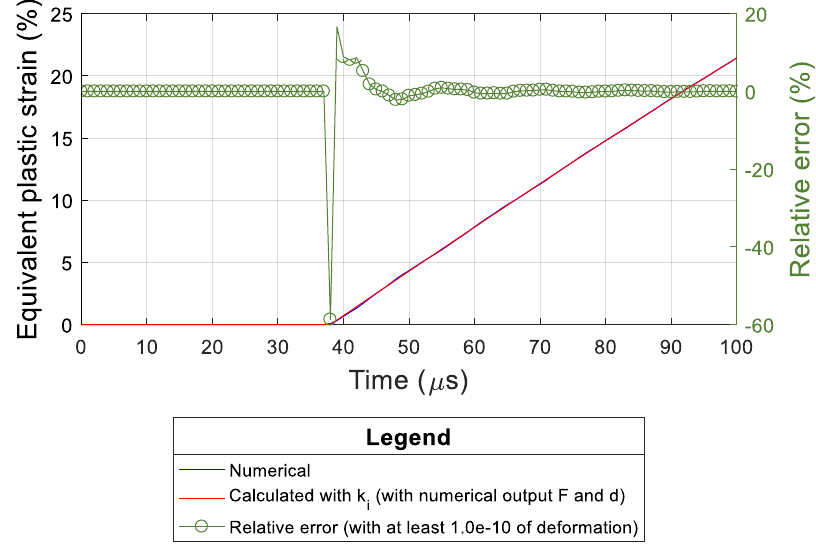
Figure A6. Comparison of ε eq,num with ε eq,calc. versus time obtained in the shear zone for numerical and processed data.